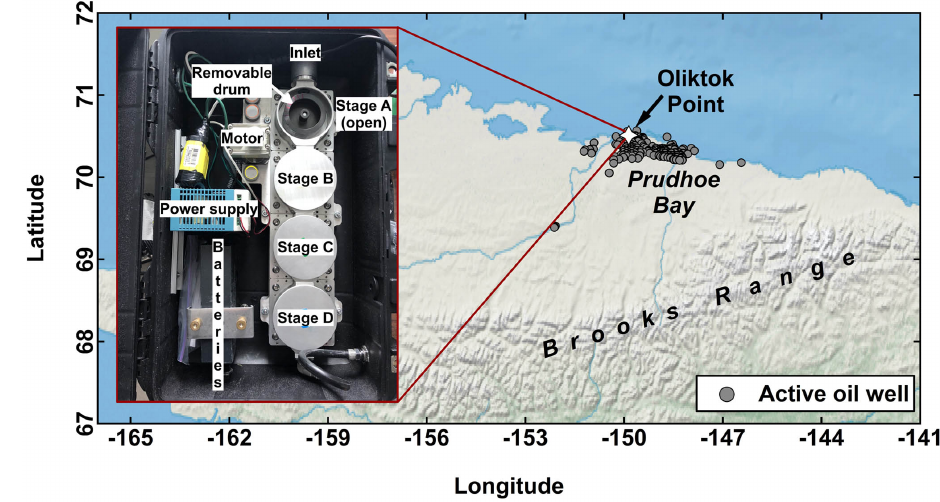
Figure 1. Map of the North Slope of Alaska highlighting Oliktok Point and oil wells that are active in Prudhoe Bay (data obtained from http://doa.alaska.gov/ogc/publicdb.html, last access: March 2017). The approximate areas of Prudhoe Bay and the Brooks Mountain range are shown. The inset shows the inside of the DRUM case, with stage A exposed (i.e., cover removed) and major components